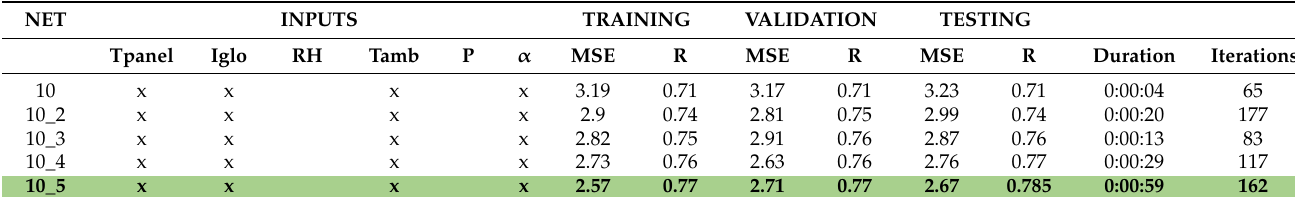
Table 4. ANN Model 1 results with more than 10 neurons.